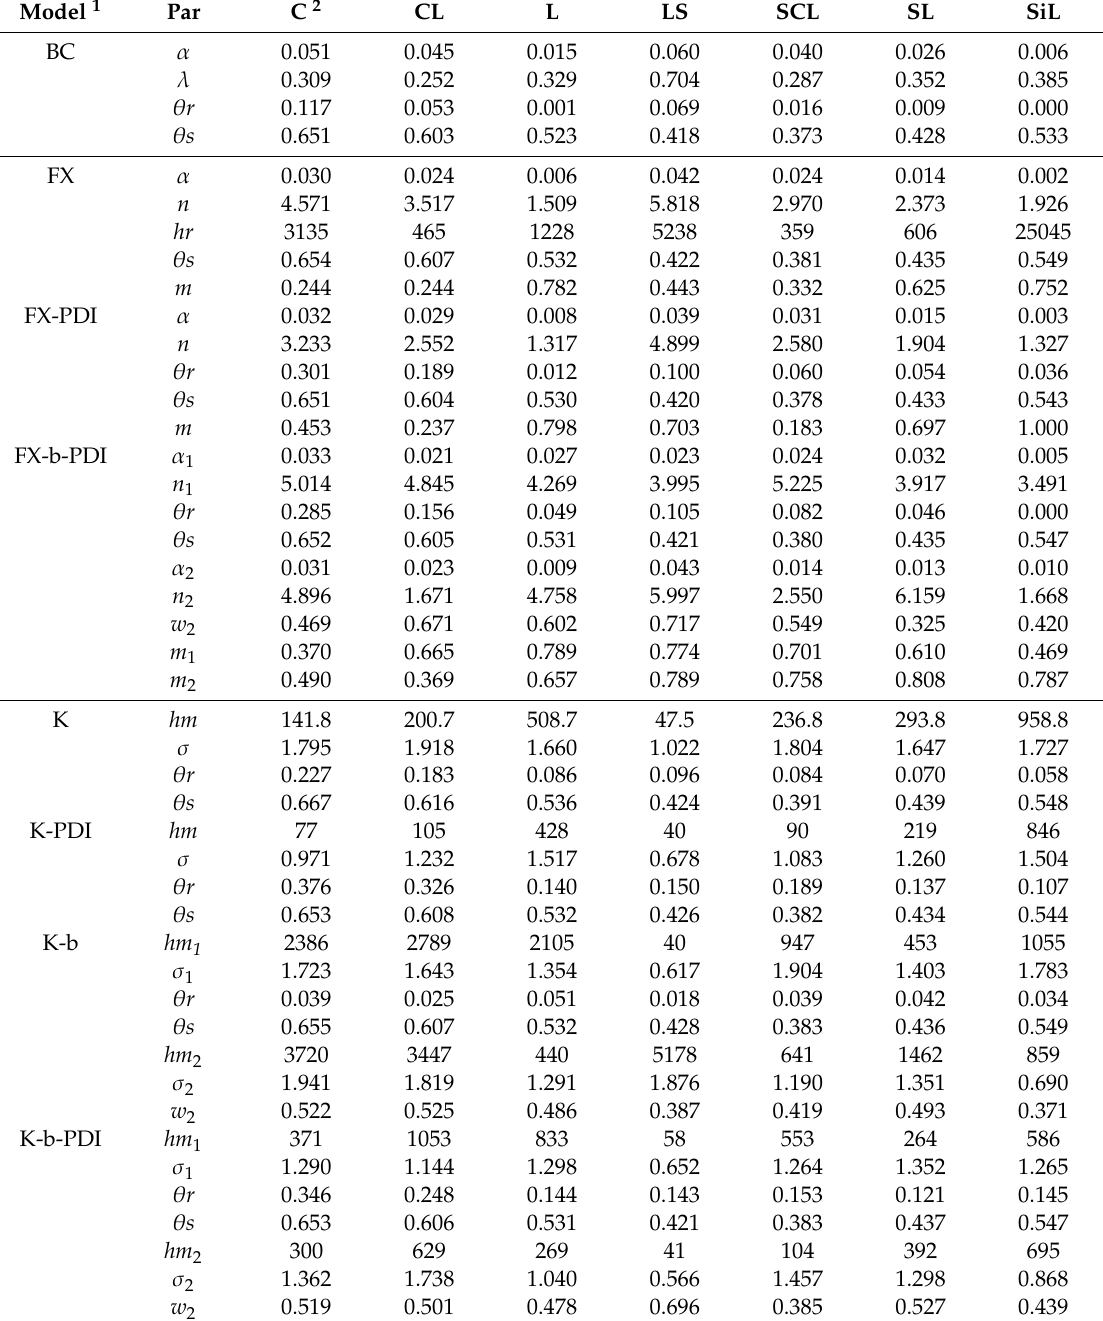
Table A1. Average values of the fitted model parameters for the 16 models across textural classes. Model